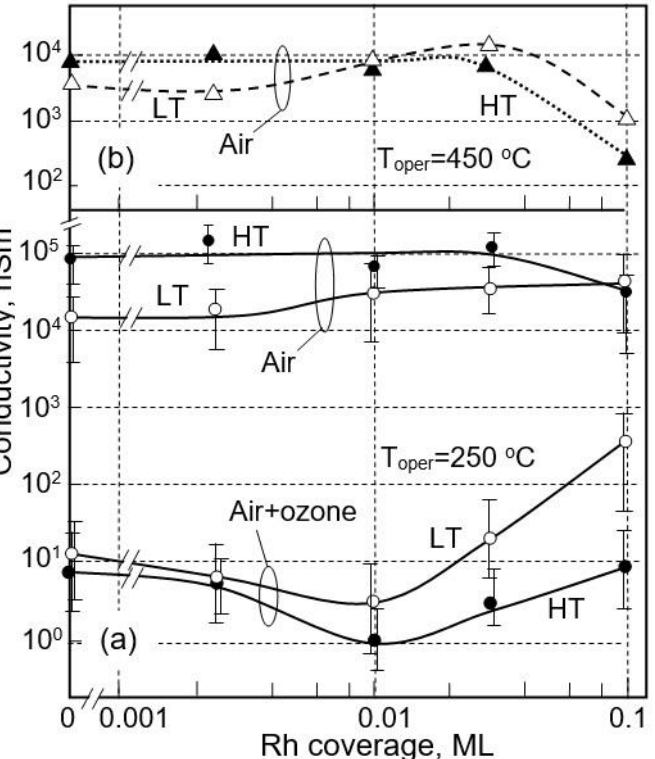
Figure 2. Change in the conductivity of LT and HT of In 2 O 3 films after surface modification with rhodium, measured in an atmosphere of air and ozone at a temperature ( a ) 250 °С and ( b ) 450 °С.